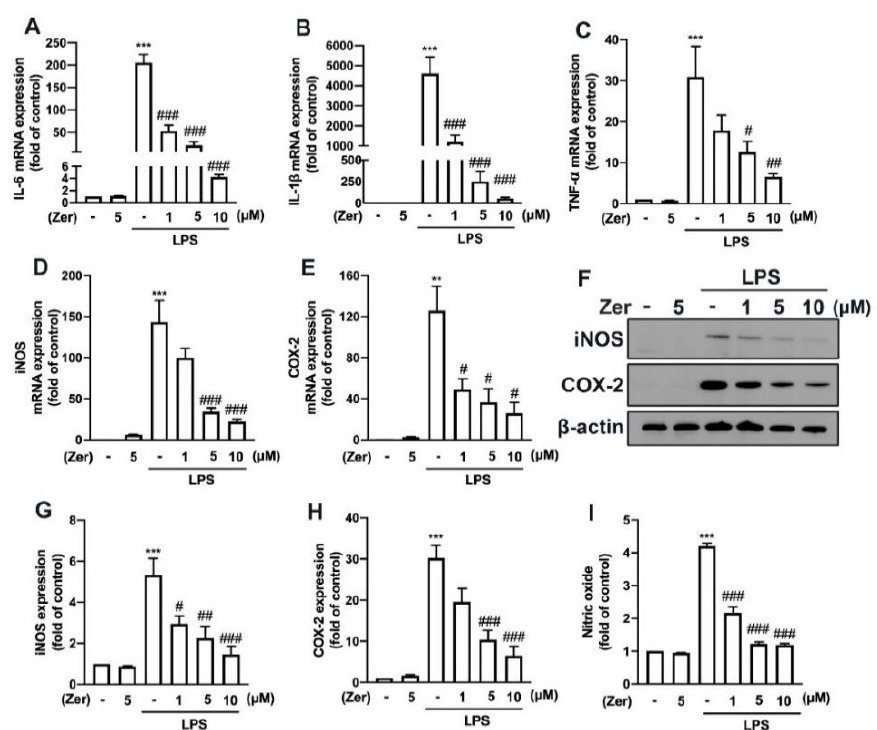
Figure 6. The expression of proinflammatory mediators in response to zerumbone in microglia. IMG cells were supplemented with different concentrations of zerumbone (1, 5, or 10 µ M) for 30 min and administered with LPS (50 ng/mL) for another 6 h ( A – C ) or 24 h ( D – G ). IL-6 ( A ), IL-1 β ( B ), TNF- α ( C ), iNOS ( D ), and COX-2 ( E ) mRNA expressions were analyzed using real-time PCR and normalized to β -actin. ( F ) iNOS and COX-2 protein expressions were analyzed using Western blotting. Quantitative results are shown in ( G , H ). ( I ) The cultural supernatant was harvested for measuring NO production by NO assay. Each bar represents the mean ± SEM ( n = 3 or 4). ** p < 0.01, *** p < 0.005 compared with the control group. # p < 0.05, ## p < 0.01, ### p < 0.005 compared with the LPS alone group.